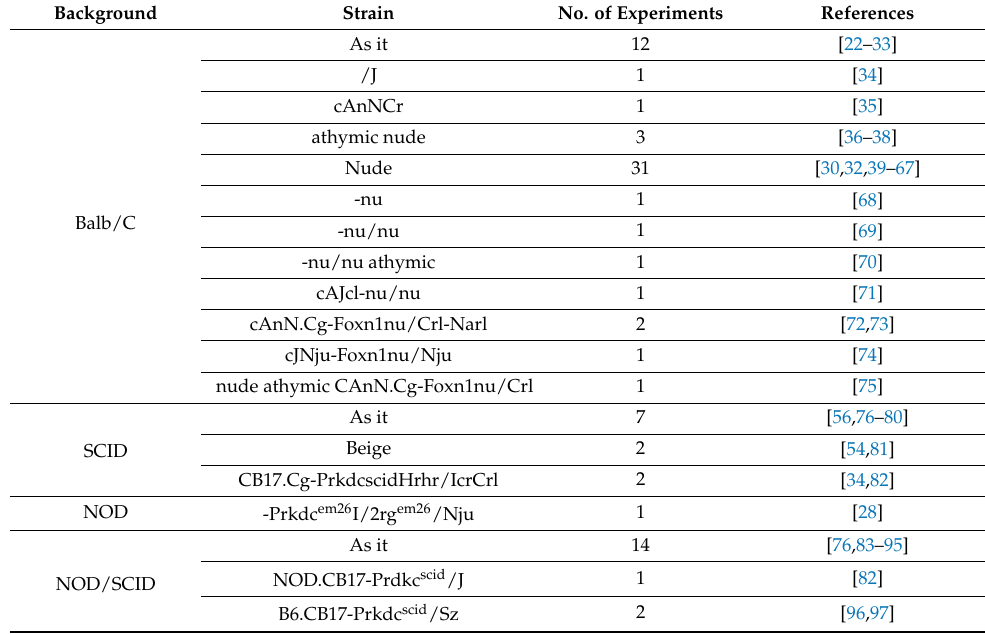
Table 1. Murine strains used in miRNA